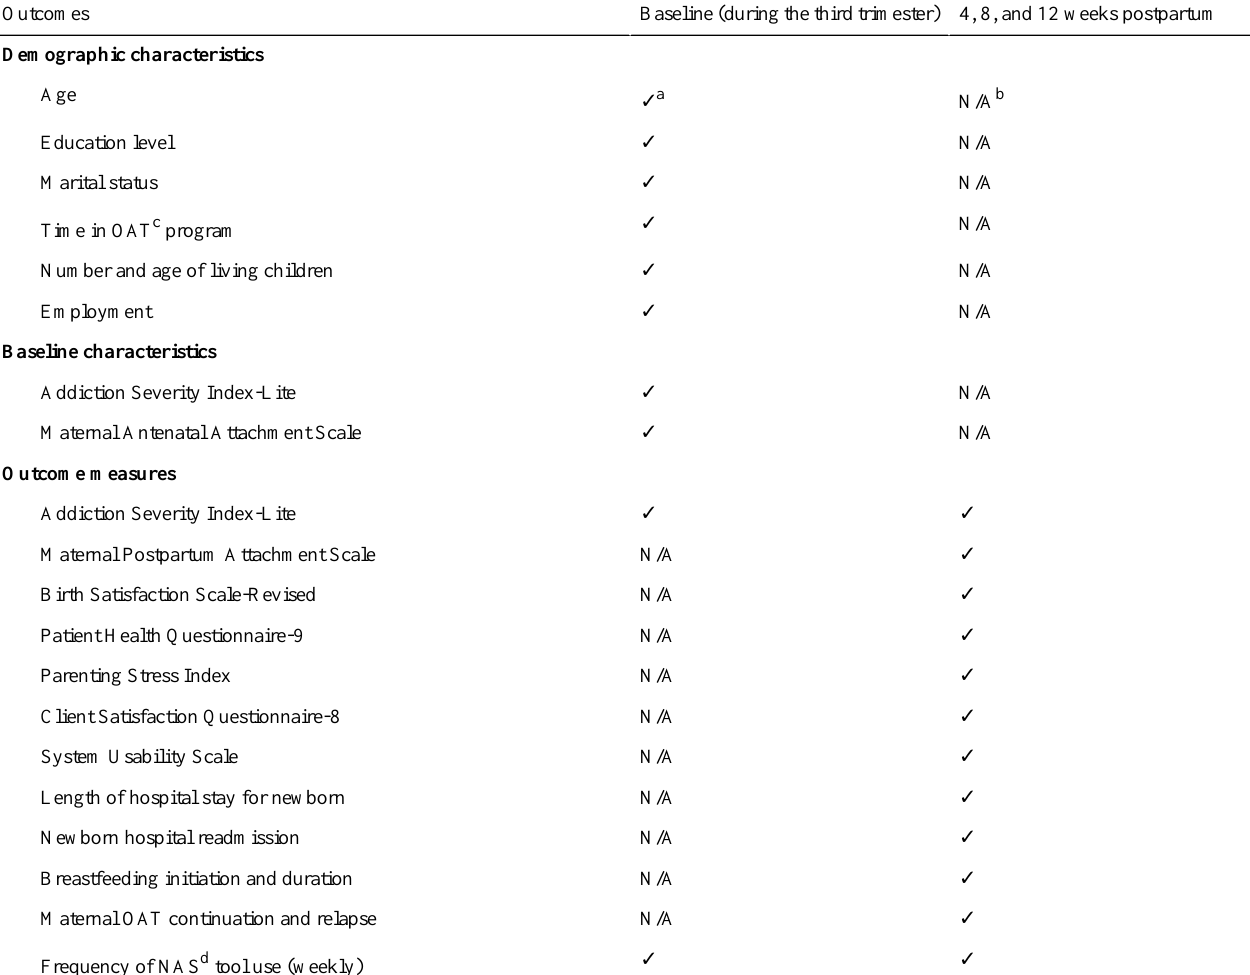
4, 8, and 12 weeks postpartumBaseline (during the third trimester)Outcomes